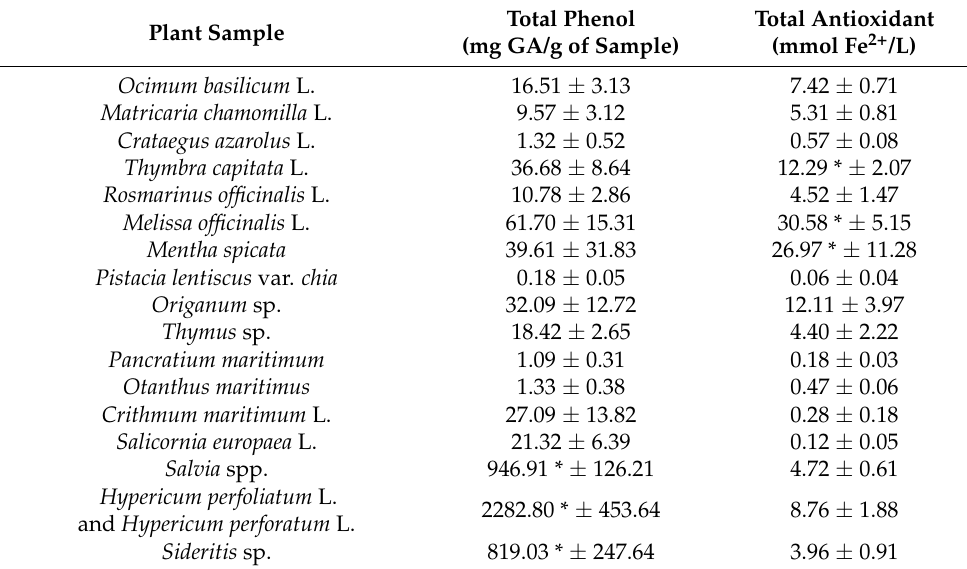
Table 1. Total phenolic and antioxidant contents of the 17 studied herbs and wild greens. Total Plant Sample